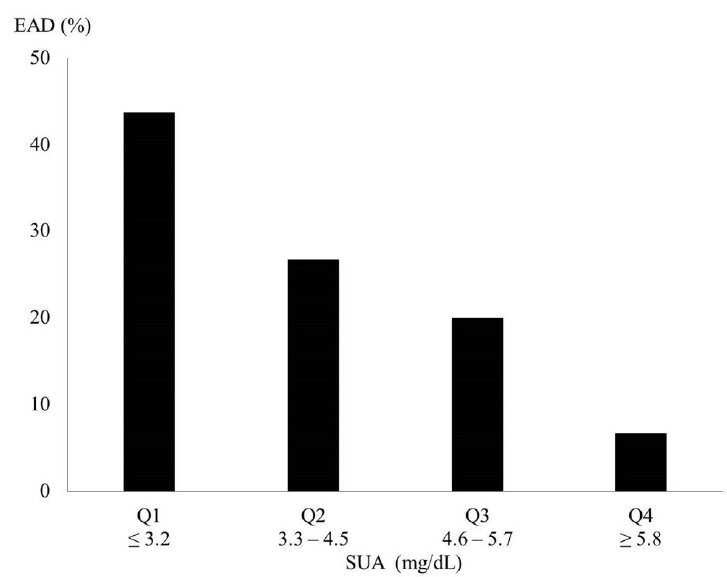
Figure 3. Incidence of EAD in association with the levels of preoperative SUA. SUA, serum uric acid; EAD, early allograft dysfunction.